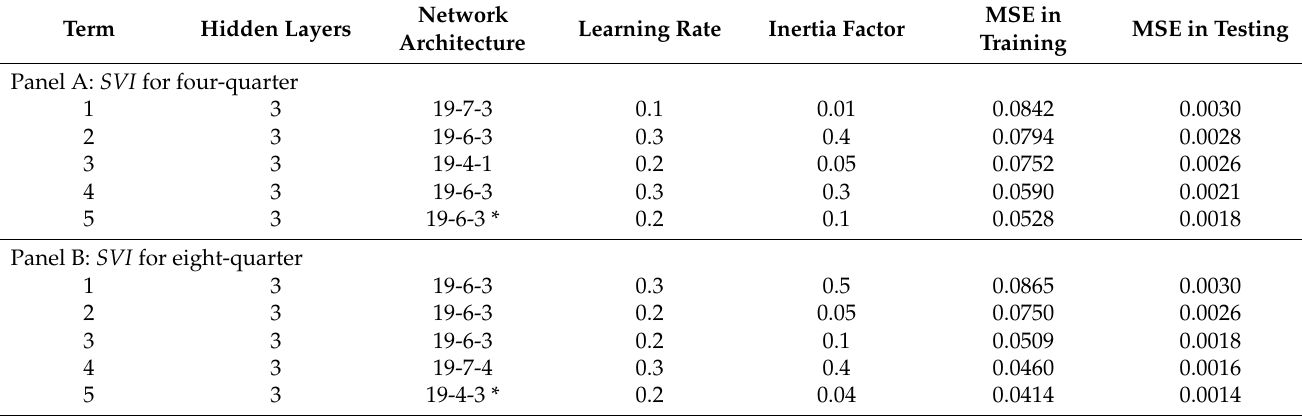
Table 2. The network architecture